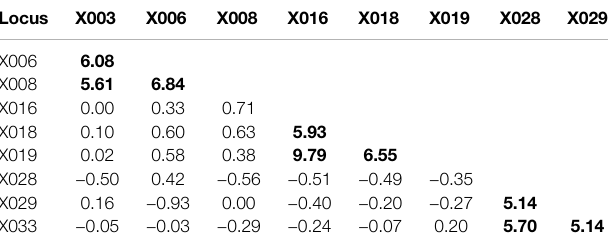
TABLE 5 | Log odds (LOD) scores for all pairs of loci.